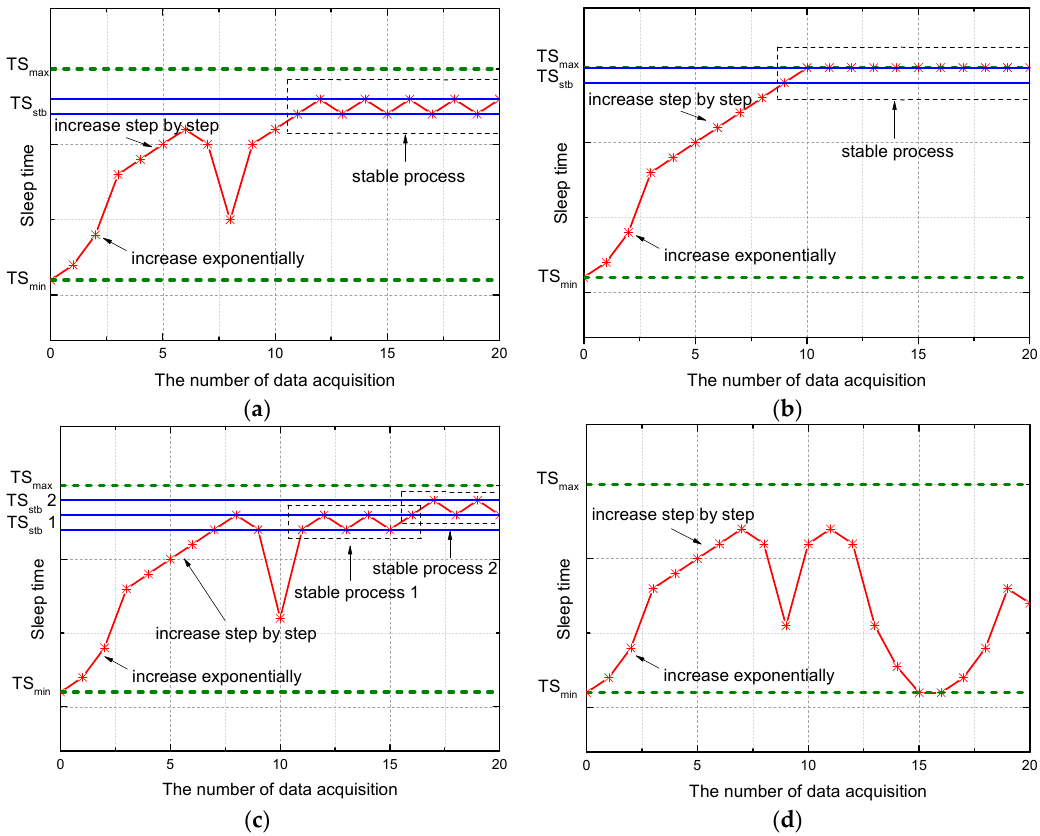
Figure 2. The change in the sleep time of temporal data-driven sleep scheduling (TDSS) with different inputs. ( a ) sinusoidal signal τ sin( ω t ) as the input of TDSS; ( b ) constant value as the input of TDSS; ( c ) inclination of metro tunnel without metro operation; and ( d ) inclination of metro tunnel with metro operation.